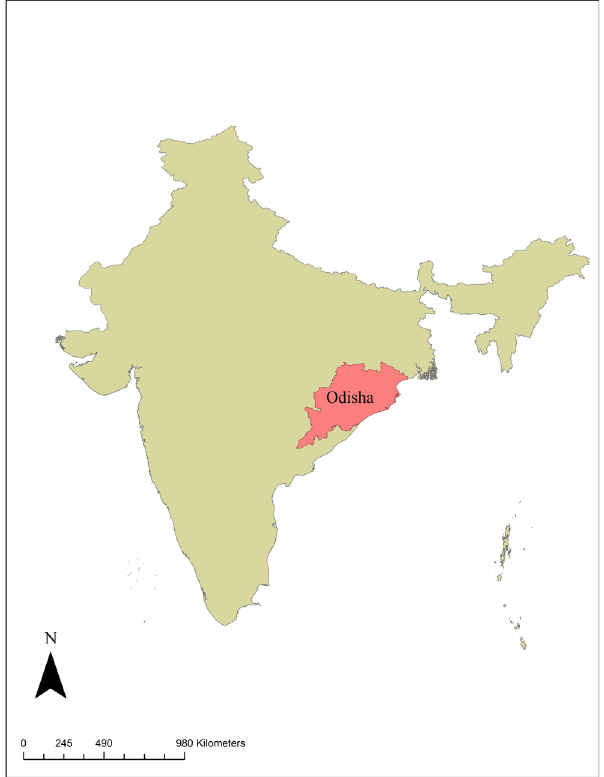
Fig 1. Map of India, highlighting Odisha State. (Map generated in ArcGIS